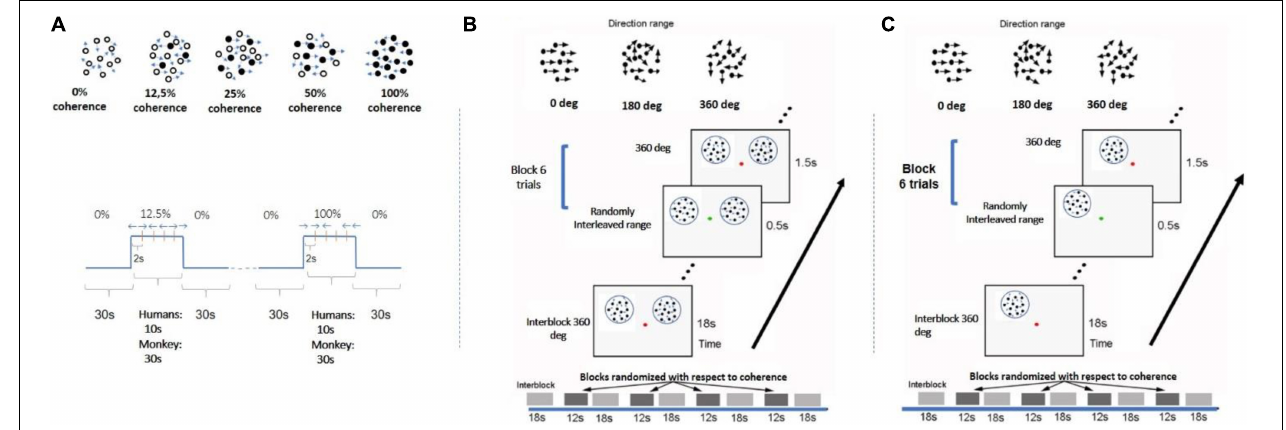
FIGURE 1 | Experimental design. (A) Paradigm used in study A. Each motion coherence was presented for 10 s interleaved with 30 s of 0% coherence (no correlation among dots). All coherence levels appear for the same total time in each scan. Each scan either consisted of two blocks of each of four pseudorandomly interleaved coherence levels (12.5, 25, 50, 100%) or four trials of each of three pseudorandomly interleaved coherence levels (25, 50, 100%). Within each block with non-zero coherence, the global direction changed (left vs. right) every 2 s to minimize adaptation. A similar paradigm was used for the monkey experiment except RDK duration was 30 s for all coherences. Black dots represent the group of dots moving in the same direction. (B) RDKs for study B were presented at bilaterally symmetric locations (see section “Materials and Methods”). Coherence alternated between 18 s of baseline of 360 ◦ direction-range (no global coherence) followed by 1 s of RDK coherence selected from levels (0 ◦ , 180, 288 ◦ , 360 ◦ ). All coherence levels were pseudorandomly interleaved and balanced across blocks and scans. Within blocks, coherent RDKs were presented for 0.5 s for six trials (see section “Materials and Methods”) and directions of motion changed every 2 s, with left and right directions appropriately balanced but presented at random sequence (so subjects could not predict the direction). Subjects were fixating and cued by a change in the color of the fixation spot to report the direction of the stimulus in one hemifield. (C) A similar paradigm to B except now RDKs were presented unilaterally. Motion-discrimination versus no-motion-discrimination sessions were interleaved in the